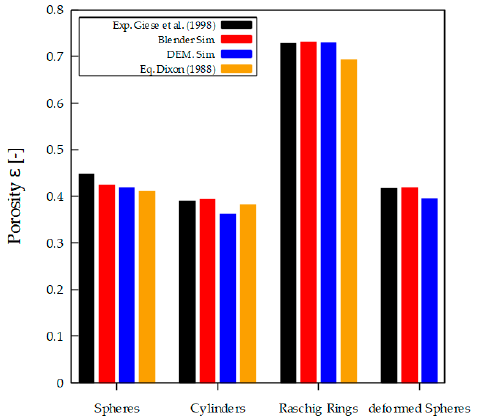
Figure 4. Overall porosity of fixed beds made of different particle shapes. Experiments from Giese et al. [30]. Equations from Dixon [43].